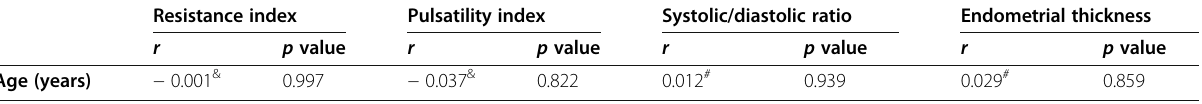
Table 2 Correlation between uterine arteries resistance index, pulsatility index, systolic/diastolic ratios, endometrial thickness, and age of the participants in the unexplained infertility (study) group